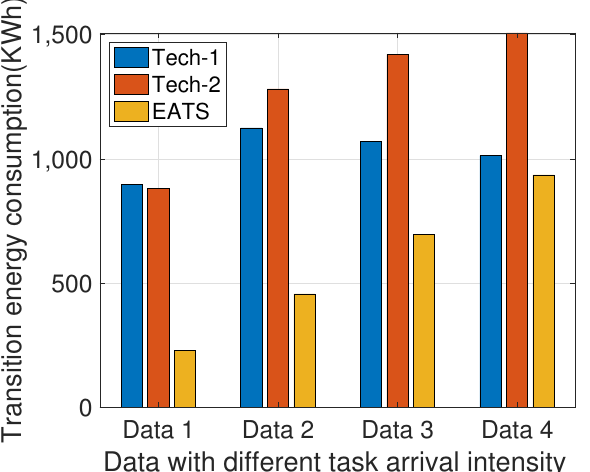
Figure 11. The comparison results of various task arrival intensities—the transition energy